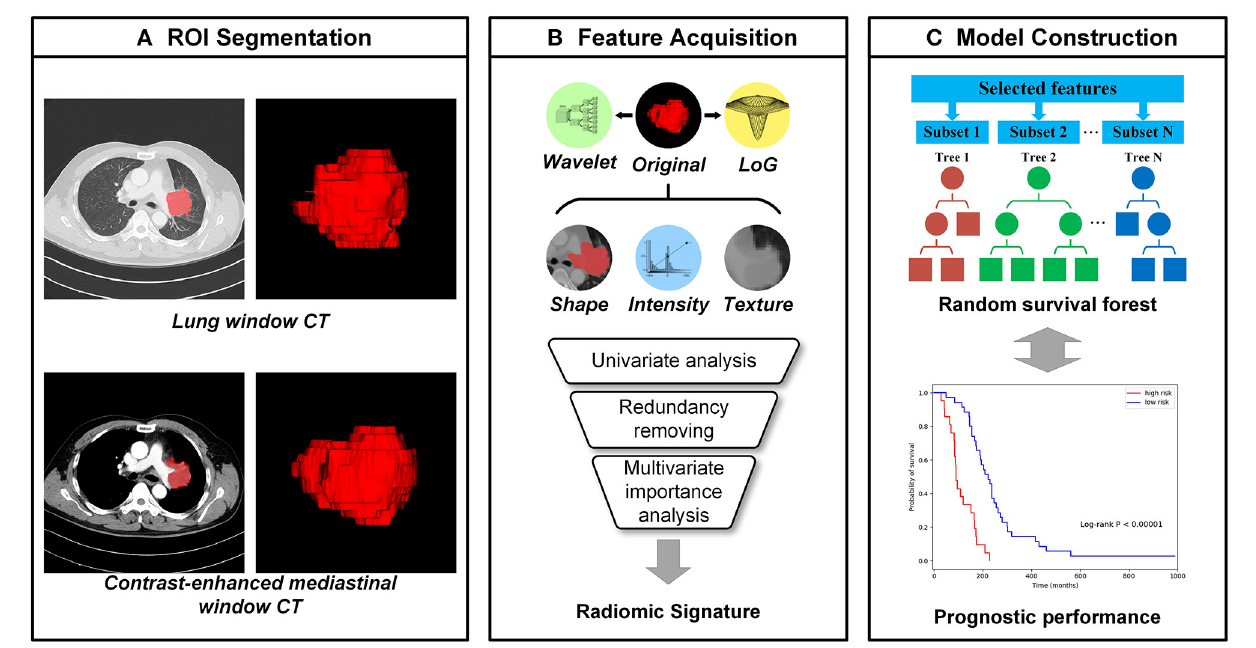
FIGURE 1 | The workflow of radiomics analysis. (A) The tumor region of interests (ROIs), which were manually segmented by an experienced radiologist from CT images with the lung window and contrast-enhanced mediastinal window, respectively; (B) the high throughput image features were extracted automatically from each ROI and the radiomic signatures were selected from them; (C) Random survival forests (RSFs) models were established for the progression-free survival (PFS)